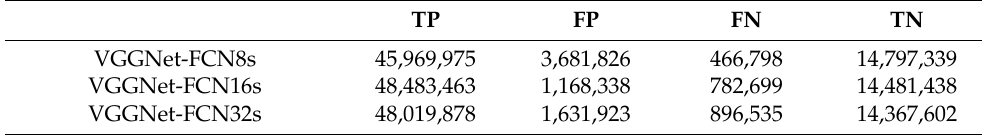
Table 1. Confusion matrix values (Pixel) of the proposed approach.